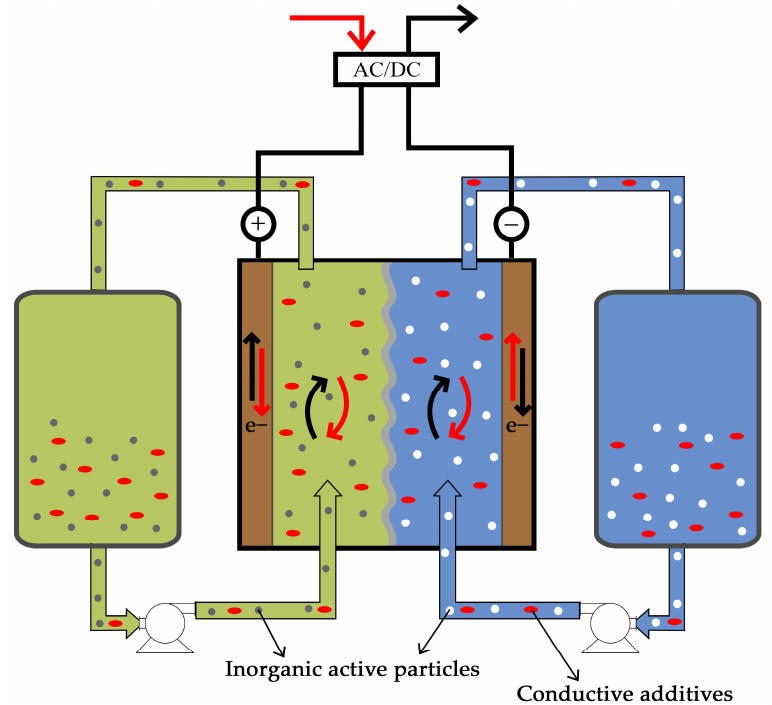
Figure 10. Representation of a semi-solid RFB without a redox mediator. Adapted from Ref. [261], Copyright 2015, Royal Society of Chemistry.